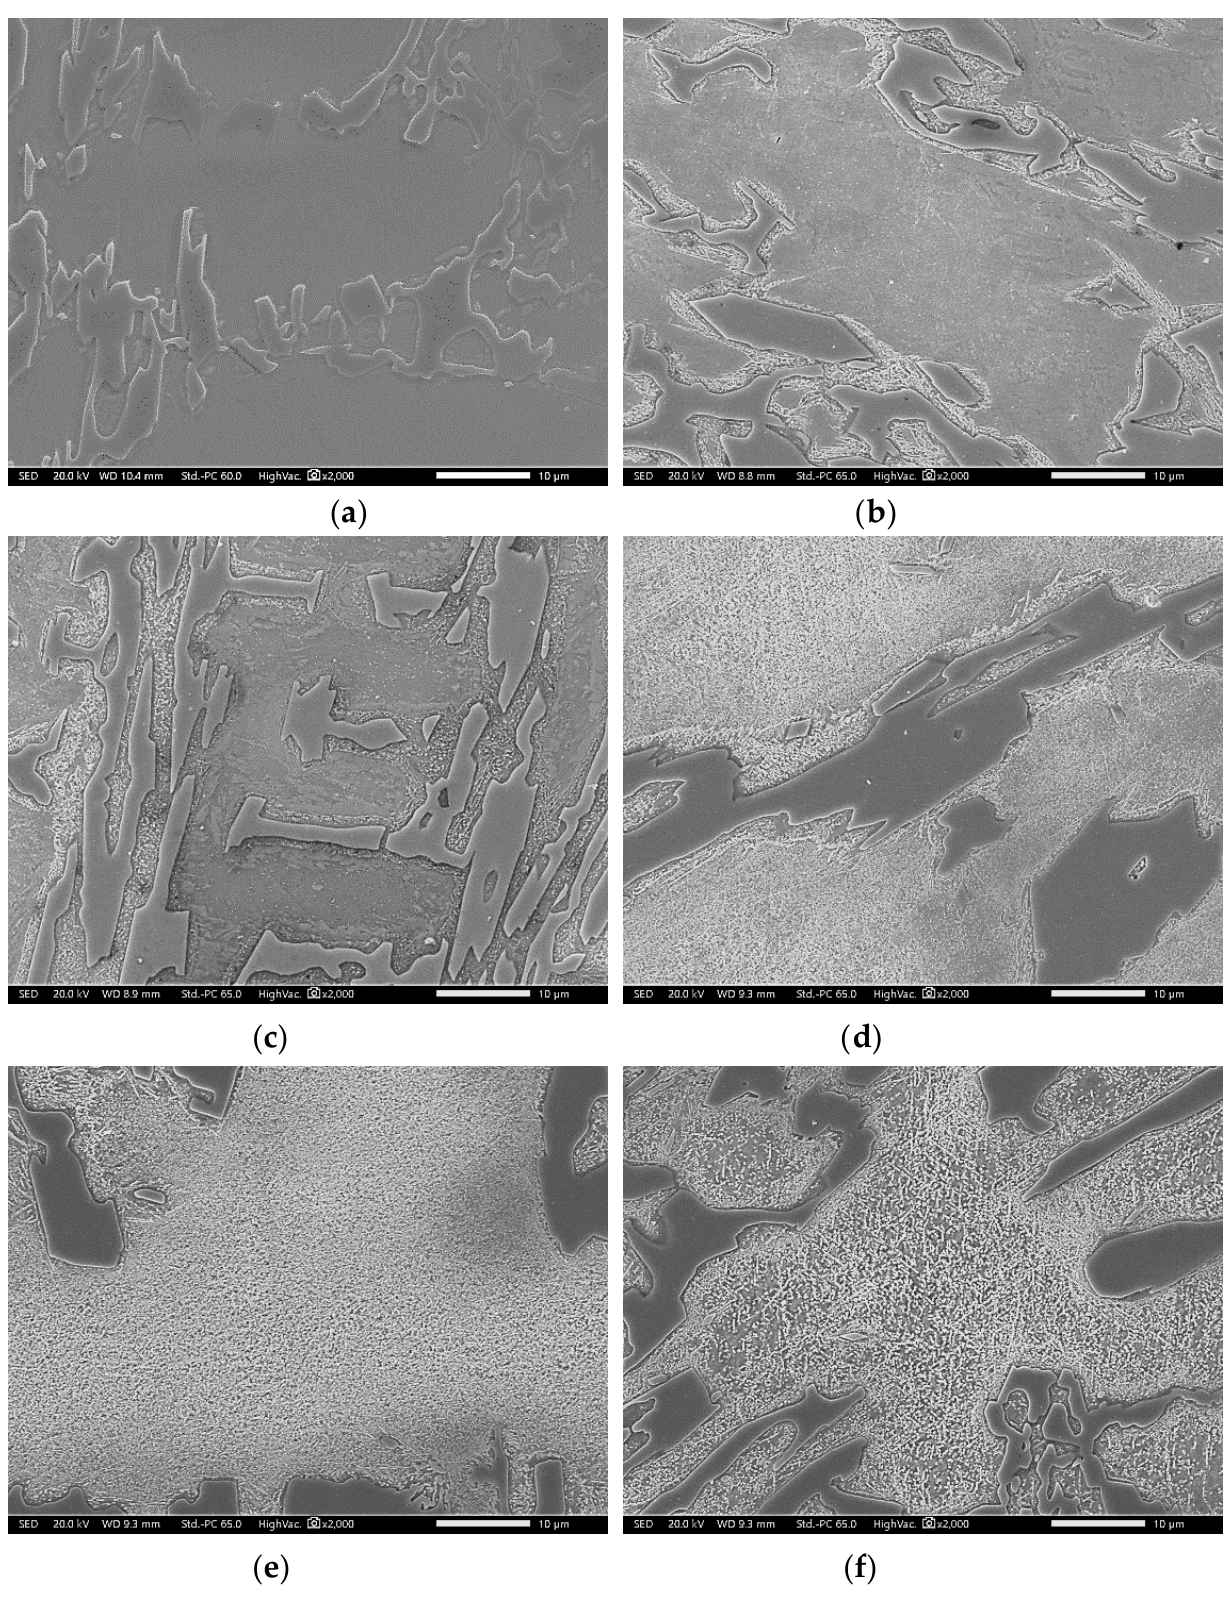
Figure 16. Effect of soaking time at 810 °C on the microstructural evolution of 2827 alloy: ( a ) as cast; ( b ) 10 min; ( c ) 30 min; ( d ) 60 min; ( e ) 240 min; ( f ) 300 min.